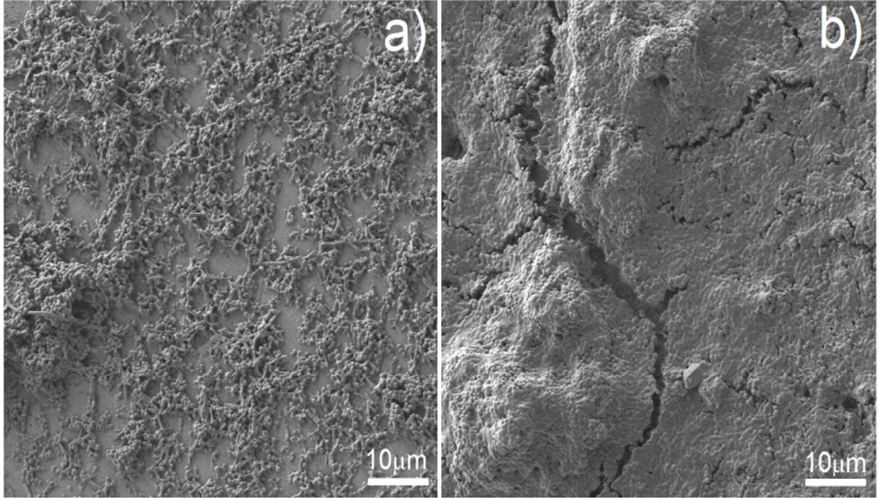
Figure 11. Pseudomonal biofilm formed on Ag-modified discs—particular cells are seen, they are not completely covered with biofilm matrix ( a ), and thick, multilayer pseudomonal biofilm formed on the control sample ( b